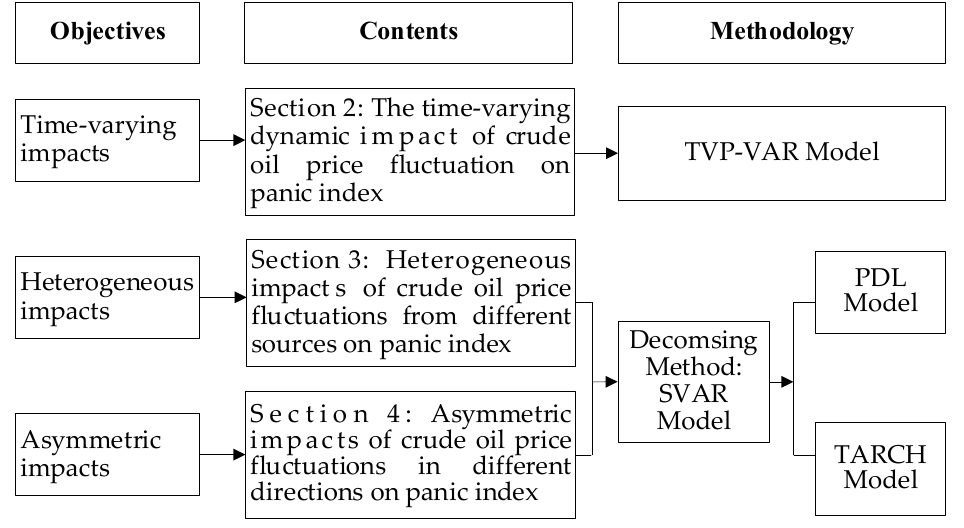
Figure 2. Framework diagram.